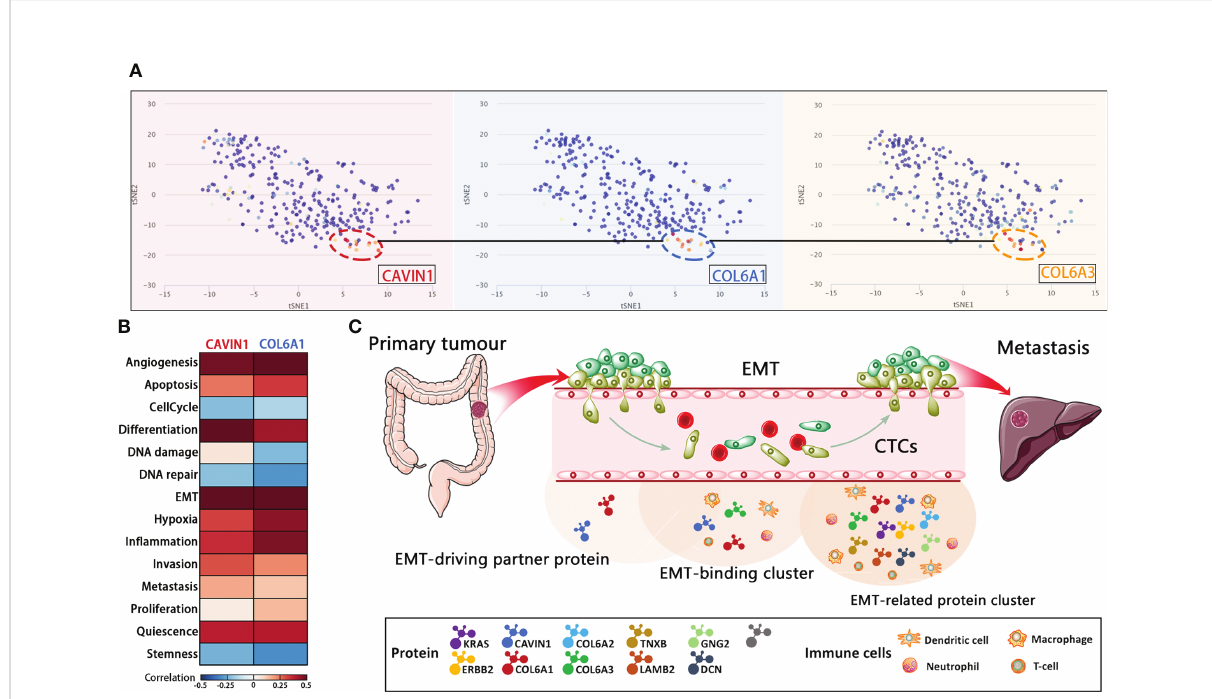
FIGURE 6 Functional analysis of the core protein and EMT-related protein cluster. (A) T-SNE describes the distribution of CRC cells. (B) Correlations between EMT-driving partner proteins and functional states in CRC single-cell datasets by CancerSEA analysis. (C) Schematic representation of EMT during the metastatic